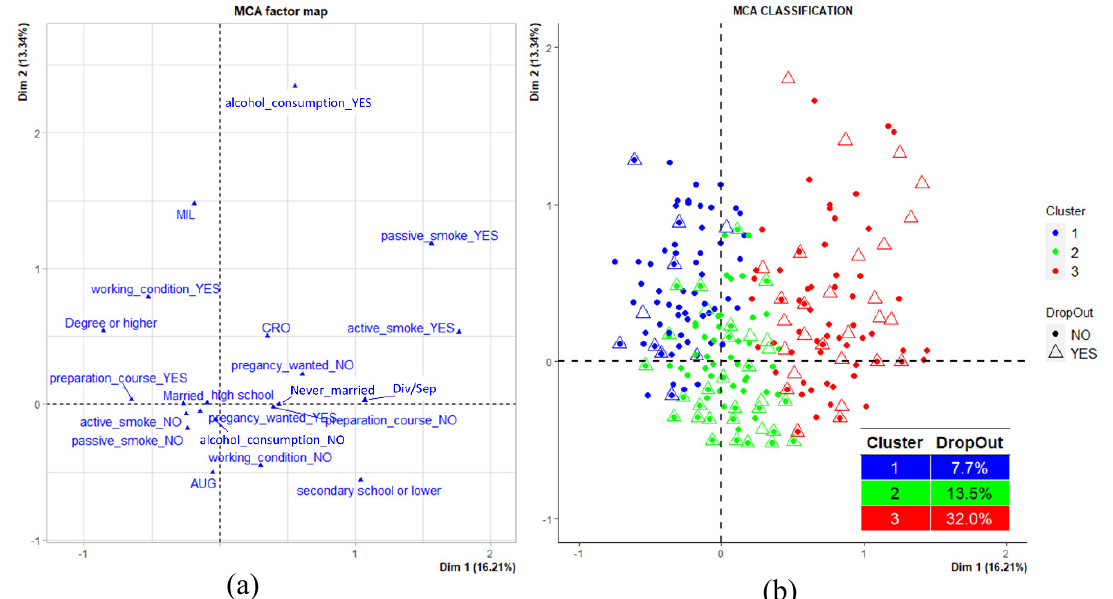
Figure 4. Multiple correspondence analysis (MCA): four dimensions described the sample, and three clusters were identified. ( a ) Dimensions describing the sample variability; ( b ) Distribution of drop out in the three clusters in MCA classification.